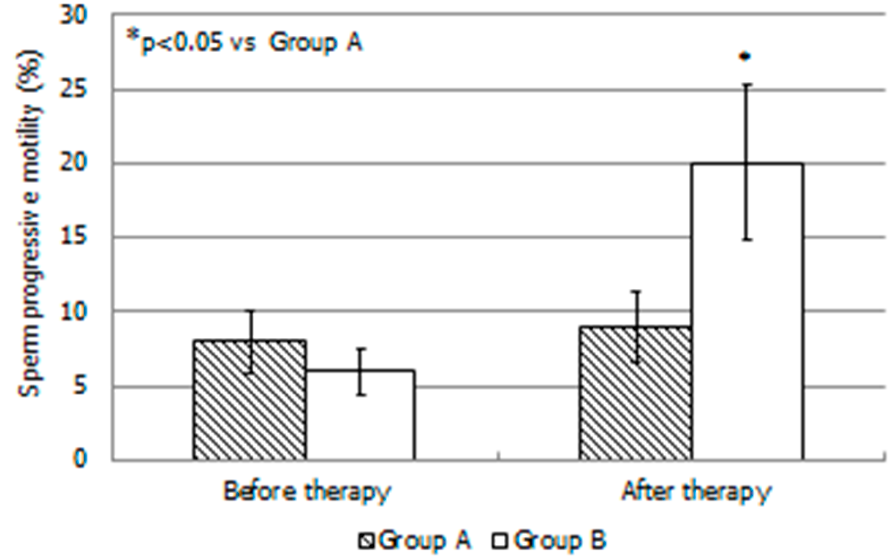
Figure 2. Sperm progressive motility in each group of patients with type 1 diabetes mellitus before and after administration of L-Acetyl-Carnitine or L-Acetyl-Carnitine plus L-Carnitine. DM1 (a) LAC 500 mg tablets every 8 hours every day for 4 months; DM (b) LAC 500 mg tablets every 8 hours and Table 1. Anthropometric, seminal, and hormonal characteristics of patients at